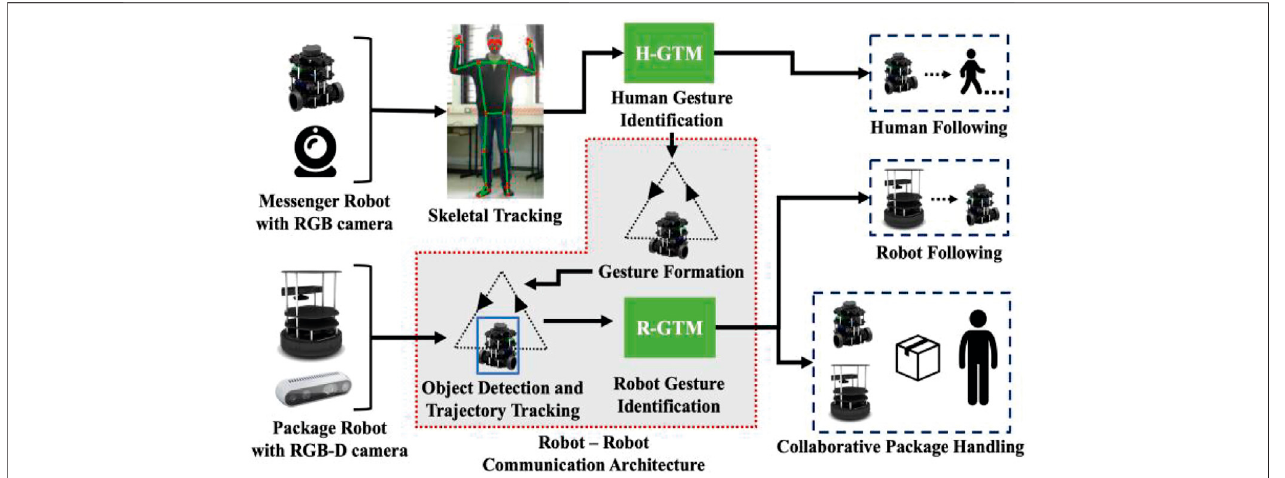
FIGURE 2 | Schematic for a collaborative vision-based gestural interaction framework. The shaded region represents the contribution of this paper.